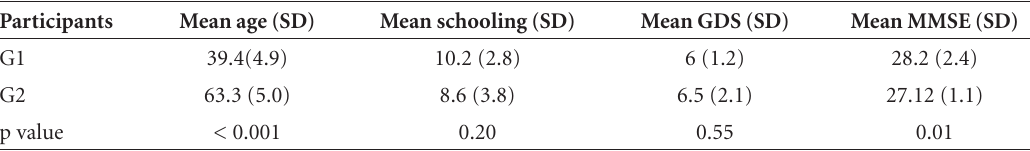
Table 1. Sociodemographic description*.